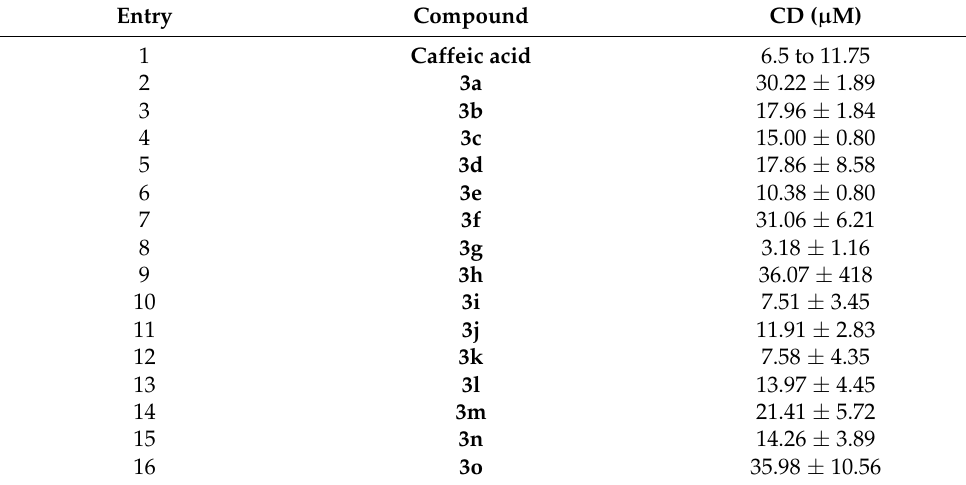
Table 5. Nrf2 induction by compounds 3 , as measured by the luciferase assay in the AREc32 cell line. CD is the compound concentration that doubles luciferase activity in comparison to its basal